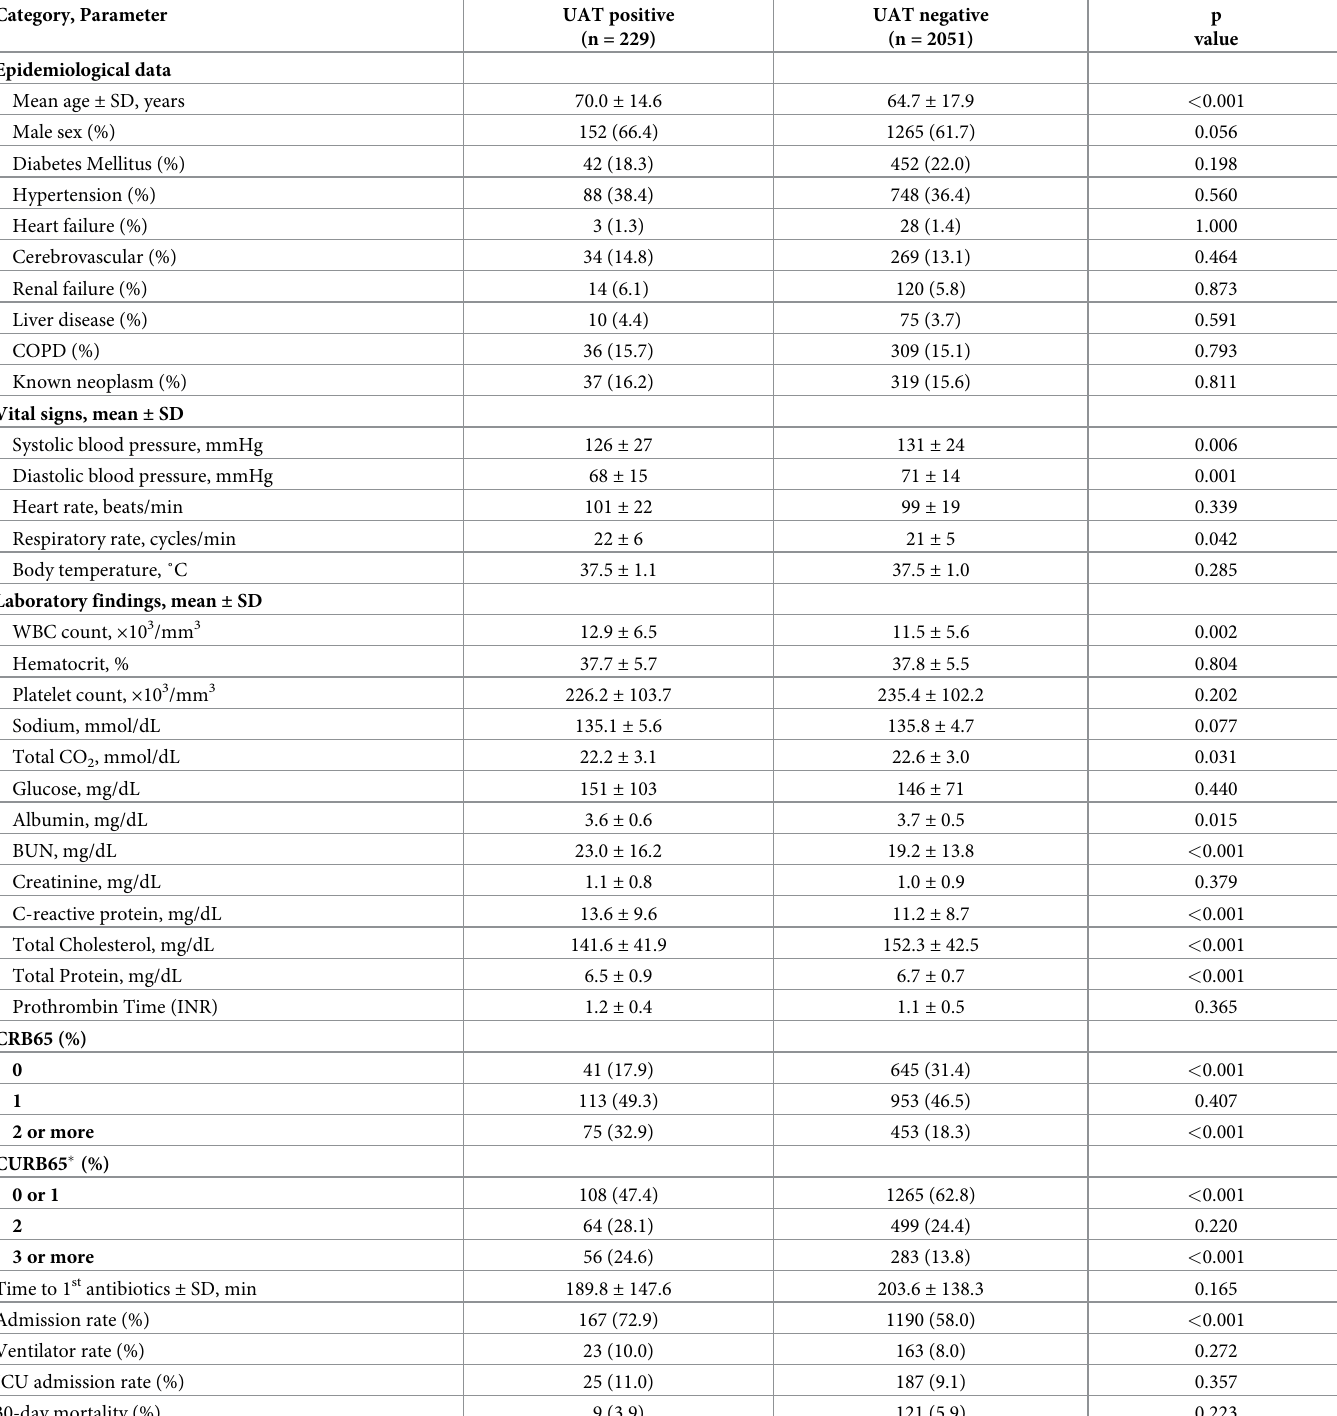
Table 2. Baseline characteristics according to UAT